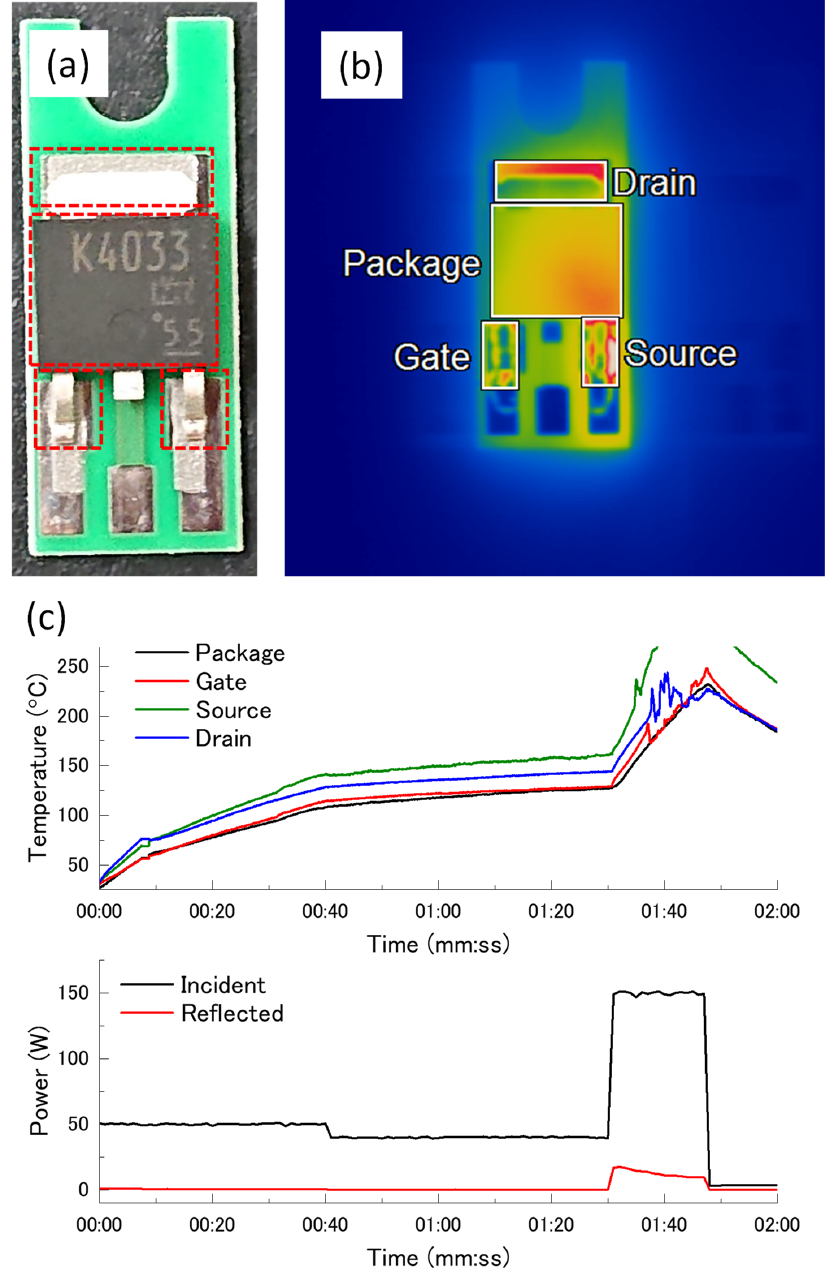
Figure 3. Photograph of sample ( a ) and thermal image of sample heated in a TM 110 cavity ( b ), and temperature (top) and power (bottom) profile for microwave heating in a TM 110 cavity ( c ). Dashed red lines in ( a ) indicate positions where temperatures were calculated. Rectangles outlined by solid white lines in ( b ) indicate regions where temperatures were highest.